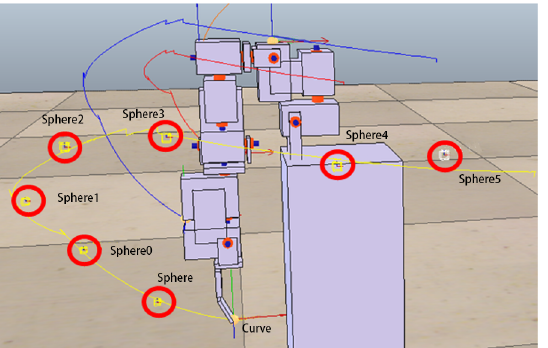
Figure 13. An example of the learning result of the ANM system when seven target points are arbitrarily selected from the trajectory of the side-lifting → swinging action.